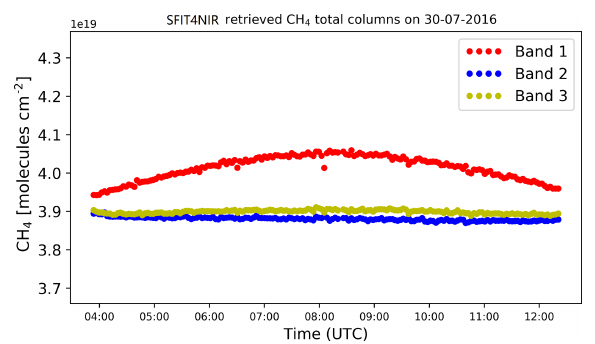
Figure 2. The SFIT4-retrieved CH 4 total columns using the three bands listed in Table 1 on 30 July 2016 (184